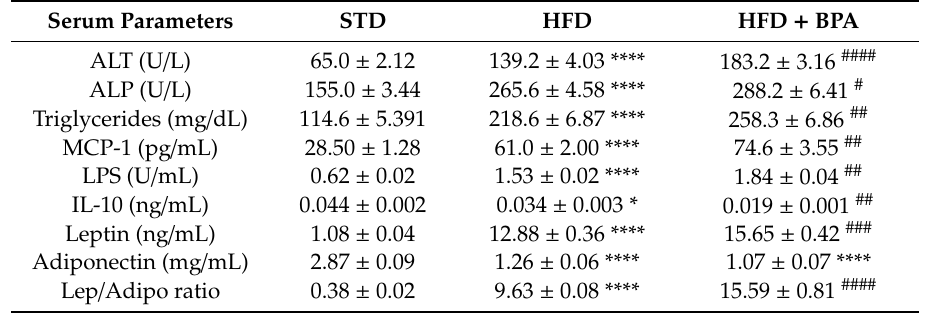
Table 1. E ff ect of BPA on serum biochemical parameters and adipokine profile in HFD mice. Serum